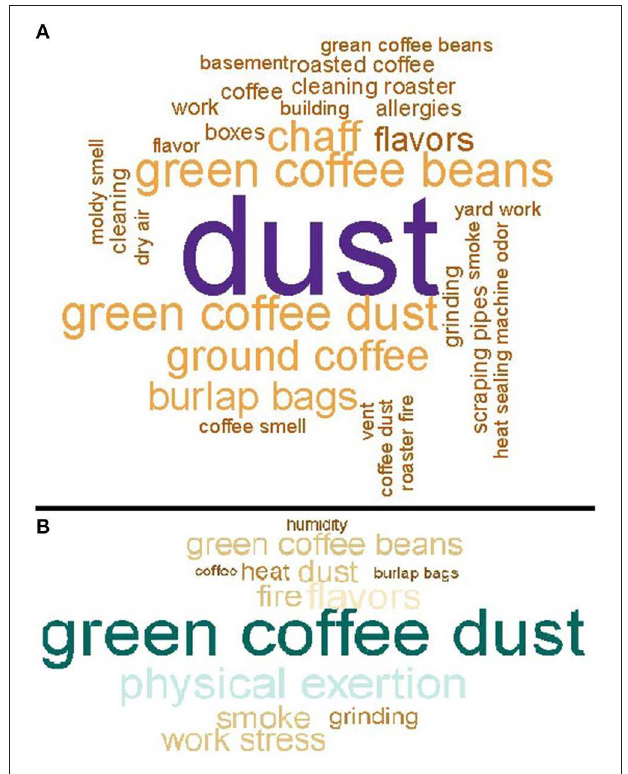
FIGURE 1 | (A) Causes or aggravations of upper respiratory symptoms at work, for workers in 17 coffee roasting and production facilities, N = 163. (B) Causes or aggravations of lower respiratory symptoms at work for workers in 17 coffee roasting and production facilities, N = 39.